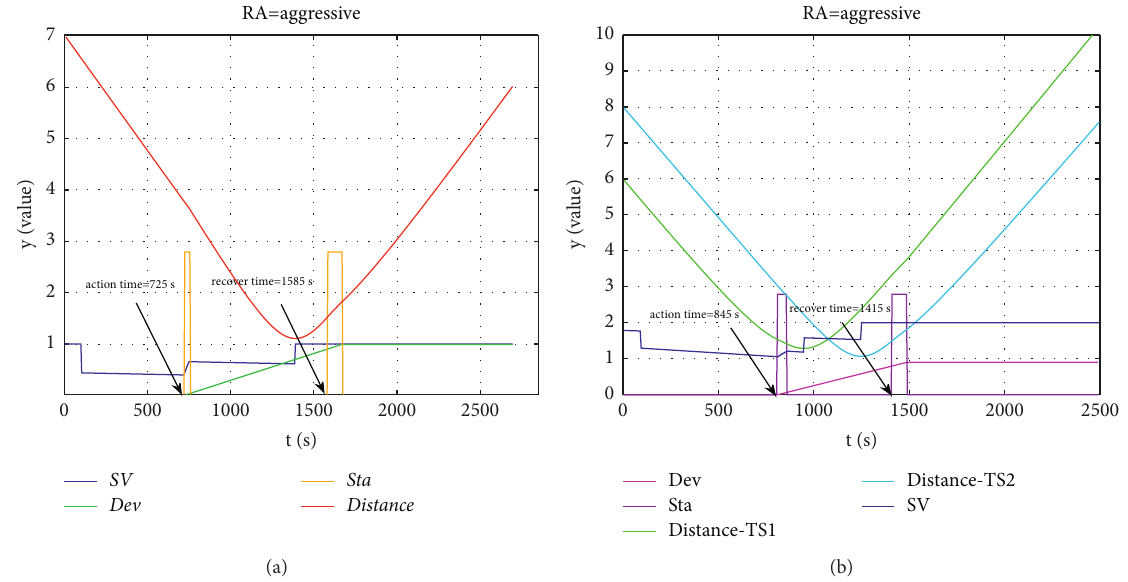
Figure 10: Results of decision indicators with aggressive officers in (a) scenario I and (b) scenario II.